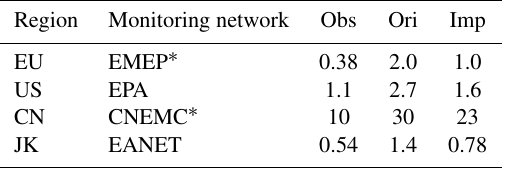
Table 3. Comparison of regional annual average values among the observed, original-simulated, and improved-simulated SO 2 mixing ratios (ppbv) in EU, USA, CN, and JK in 2015. The observed mix- ing ratios are calculated by averaging the data from all monitoring stations of various measurement networks. The simulated mixing ratios are calculated by averaging the data from all the grids where the monitoring stations are located. Region Monitoring network Obs Ori Imp EU EMEP ∗ 0.38 2.0 1.0 US EPA 1.1 2.7 1.6 CN CNEMC ∗ 10 30 JK EANET 0.54 0.78 ∗ The original units of EMEP and CNEMC are in micrograms of sulfur per cubic meter (hereafter µ gSm − 3 ) and micrograms per cubic meter (hereafter µ gm − 3 ), respectively. To facilitate compari- son,thesetwounitsareconvertedtoppbv.Unitsconversionisasfollows: